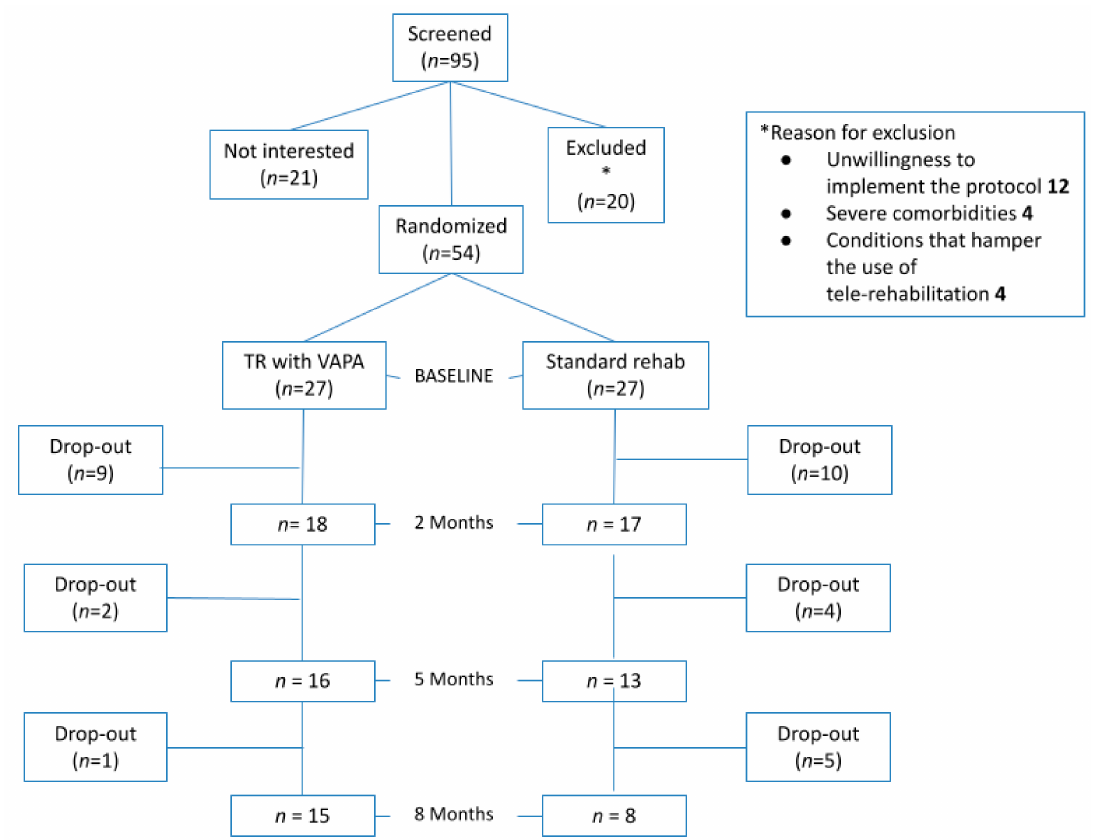
Figure 2. Randomization and enrollment in the general